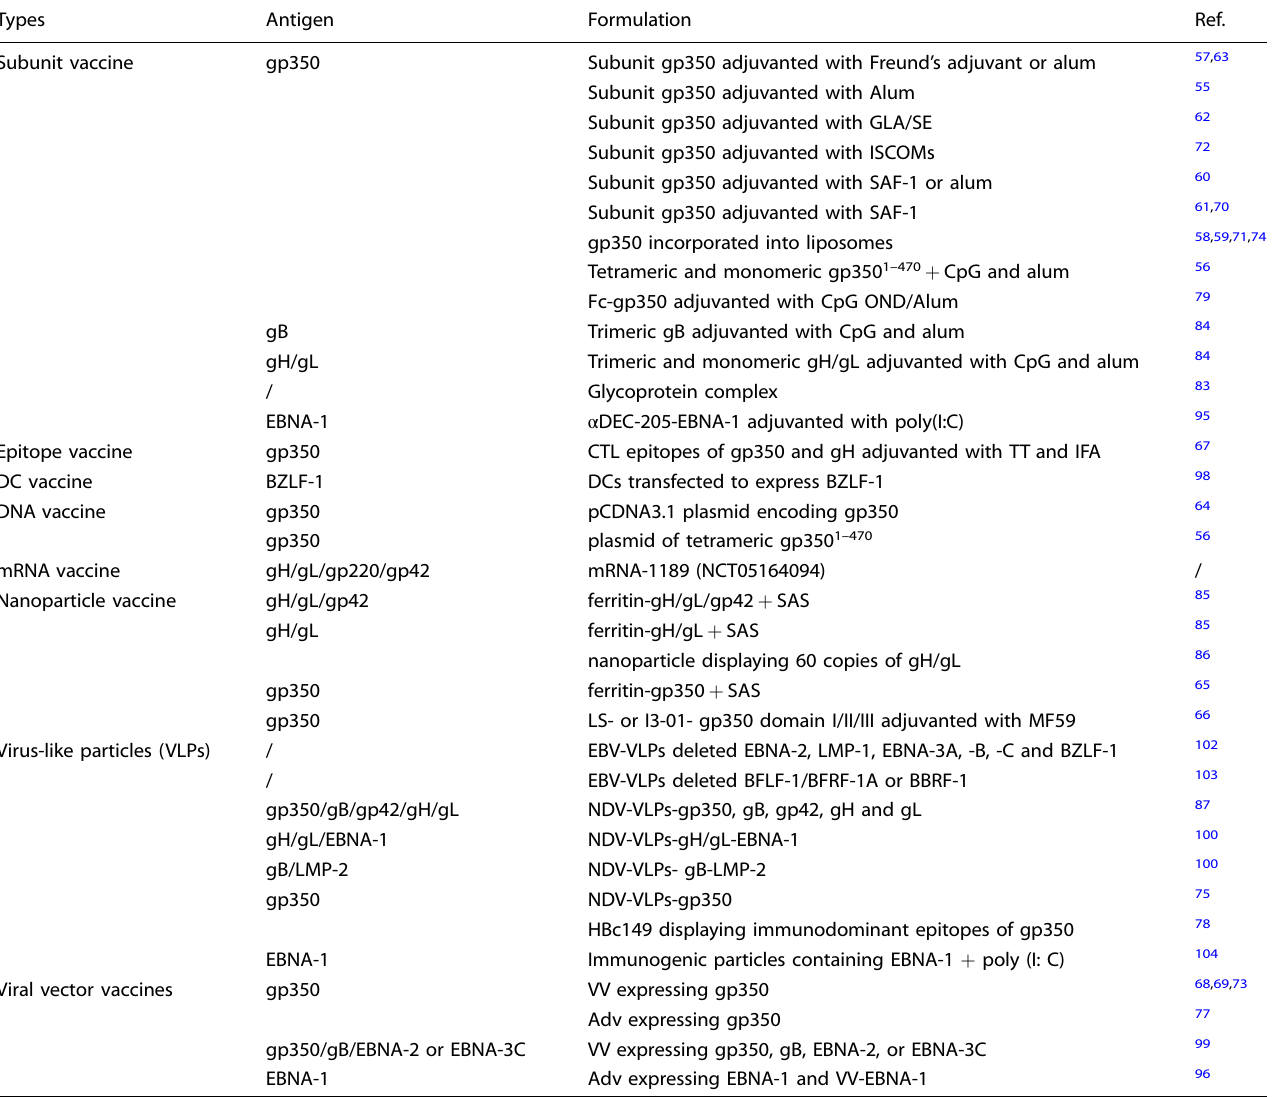
Table 1. Different types of EBV vaccine